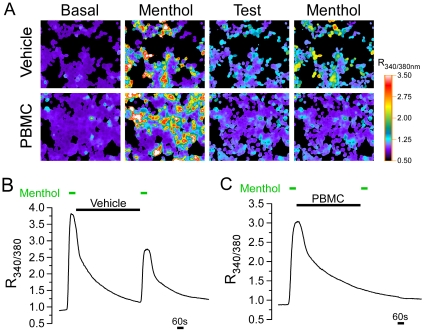
PBMC inhibits menthol-evoked TRPM8 responses.
A) Representative images of HEK293T cells expressing mTRPM8. Pseudocolored images of the 340/380 nm (excitation) Fura-2 ratio (R340/380) show low basal Ca2+ before application of 200 µM menthol, which evoked a robust increase in intracellular Ca2+. A second application of menthol resulted in a second increase in intracellular Ca2+ after a ten minute treatment with vehicle (top row) but not after treatment with 25 nM PBMC (bottom row). B) Average changes in the Fura-2 ratio of vehicle-washed menthol-responding cells show that the second menthol pulse resulted in a robust calcium influx, albeit to a smaller degree than that of the first pulse. C) Average changes in the Fura-2 ratio of cells perfused with PBMC show that the drug abolished the second calcium increase.